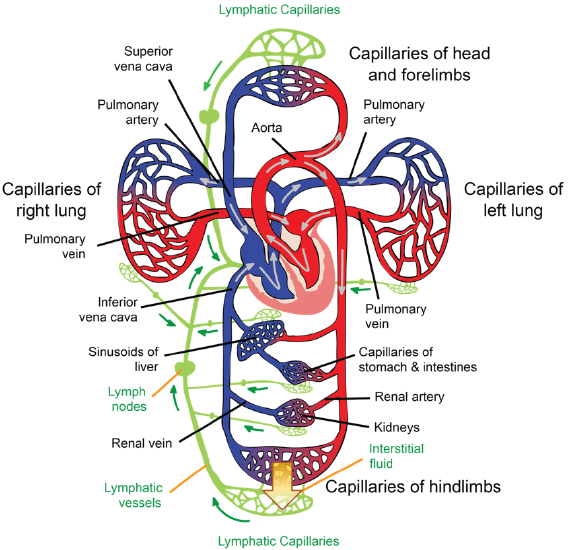
Figure 2. Illustration of the circulatory and lymphatic